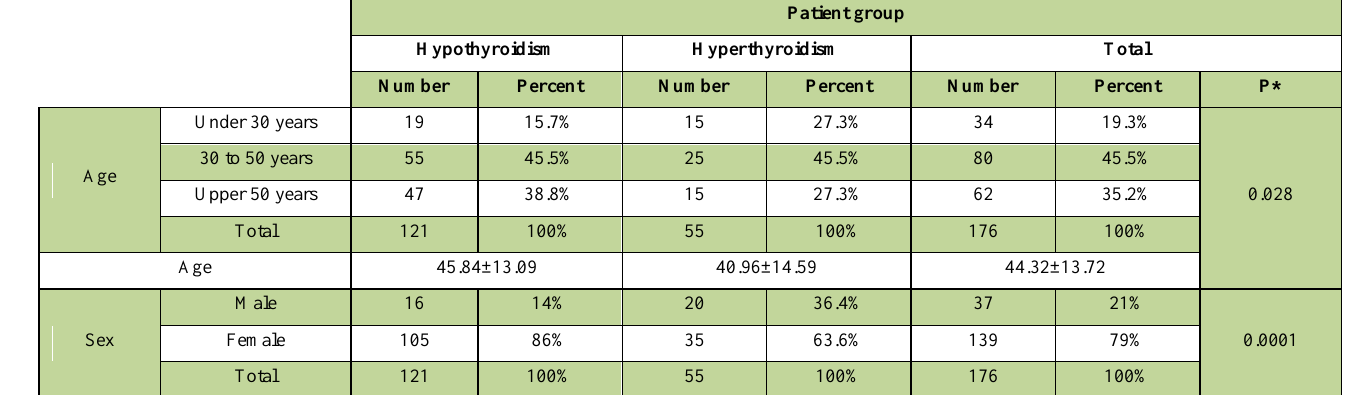
Table 1. Age and sex characteristics of the studied samples.